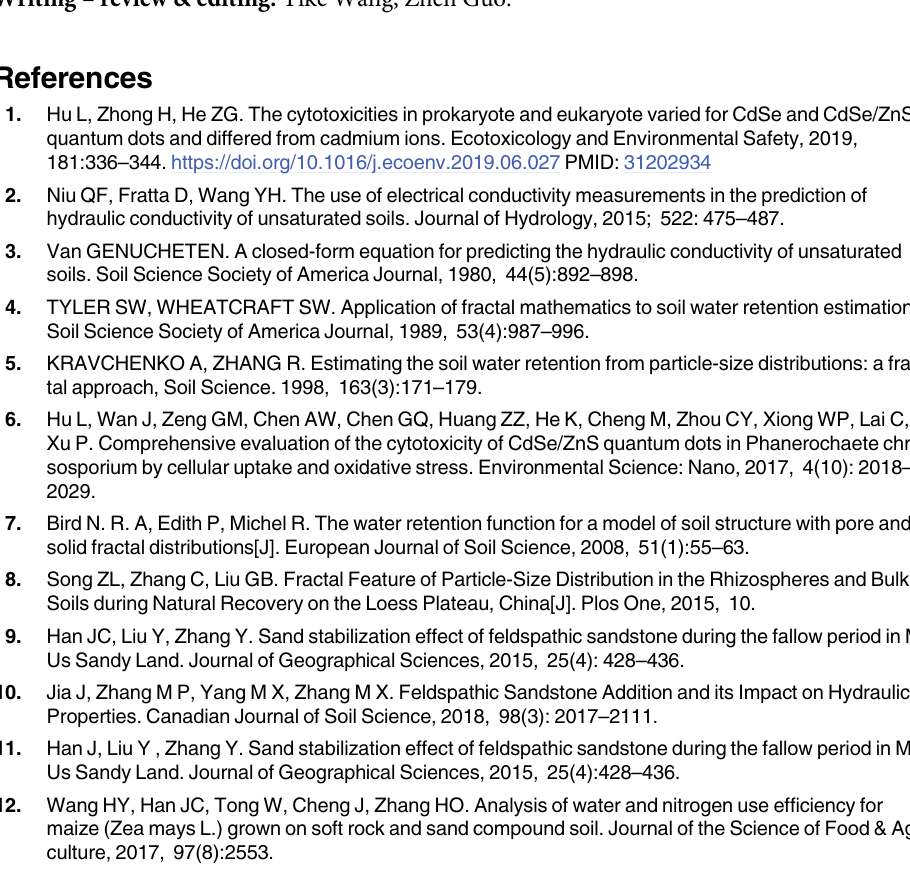
S1 Table. The water characteristic curve of soft rock and sand compound soil with differ- ent mixing